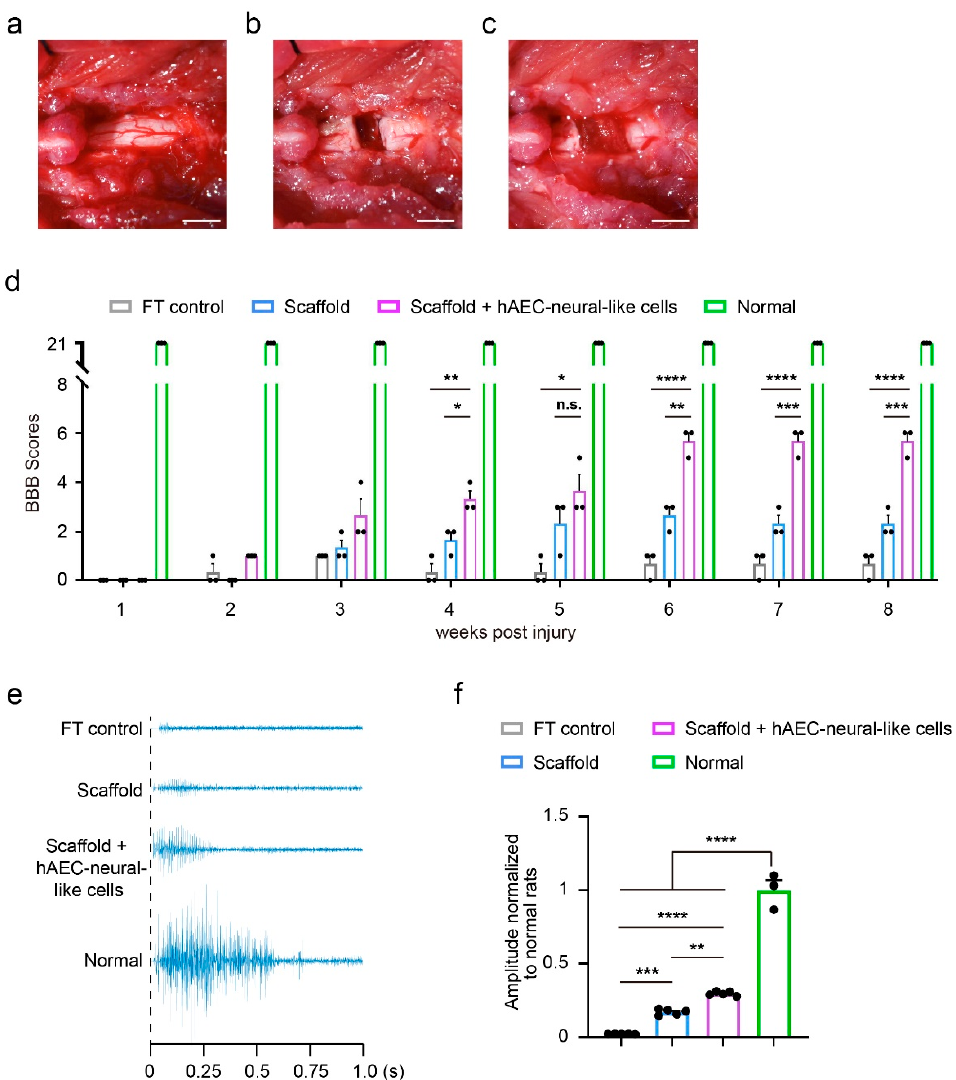
Figure 5. Implantation of hAEC-neural-like cell biomimetic scaffolds in the lesion partially rescue hindlimb locomotion in a rat model of full transection spinal cord injury. ( a – c ) The operation procedure. ( a ) Exposure of spinal cord tissue after laminectomy; ( b ) full transection operation of T10; ( c ) implantation of hAEC-neural-like cell biomimetic scaffolds into the lesion; ( d ) BBB locomotion scores within 8 weeks, one-way ANOVA followed by Bonferroni’s multiple comparisons test, n = 3 per group, **** p < 0.0001, *** p < 0.001, ** p < 0.01, * p < 0.05, n.s. not significant, error bars, SEM (the BBB scores were measured repeatedly in the same rat along 8 weeks post implantation, and the scores of rats among different groups at the same time point were analyzed to determine the statistical difference between two groups); ( e ) representative responses in the TA muscle evoked by epidural motor cortex stimulation in full transection control, empty scaffold (scaffold), hAEC-neural-like cells